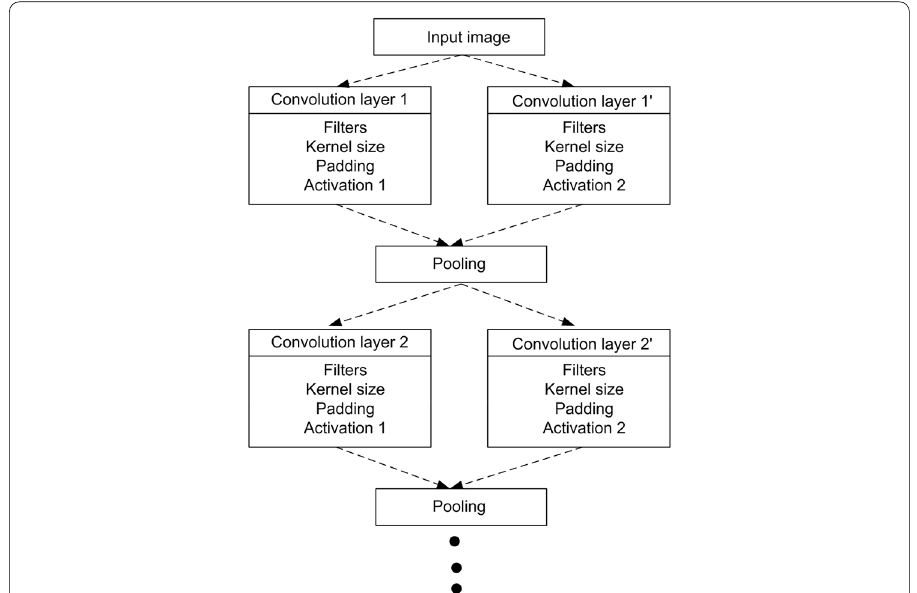
Fig. 1 The structure of the random selection of the layer parameters. The parallel layers on each level differ only by the activation function and parameter values of the filters. The input image is processed either by the left or the right side layers, and this selection is random (left or right side